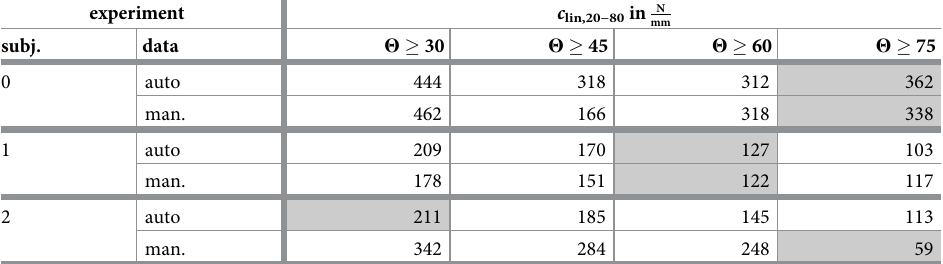
Table 1. For a selection of elbow angle sub-ranges, the linear stiffness constant between tendon lengthening at 20% max( F T 1 ) to 80% max( F T 1 ) is shown for (semi-) automatically extracted data (auto) and the manually extracted data (man.). In addition, the optimal angle sub-range is highlighted in gray for manually and automatically extracted tendon displacement (cmp. Figs 12B and 13B).